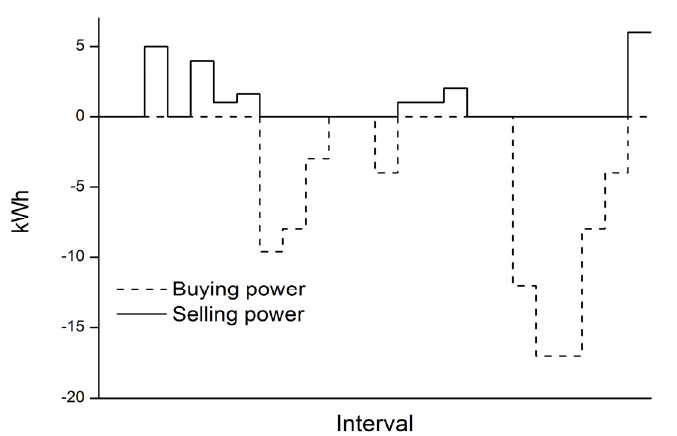
Figure 9. Power trade operated by the